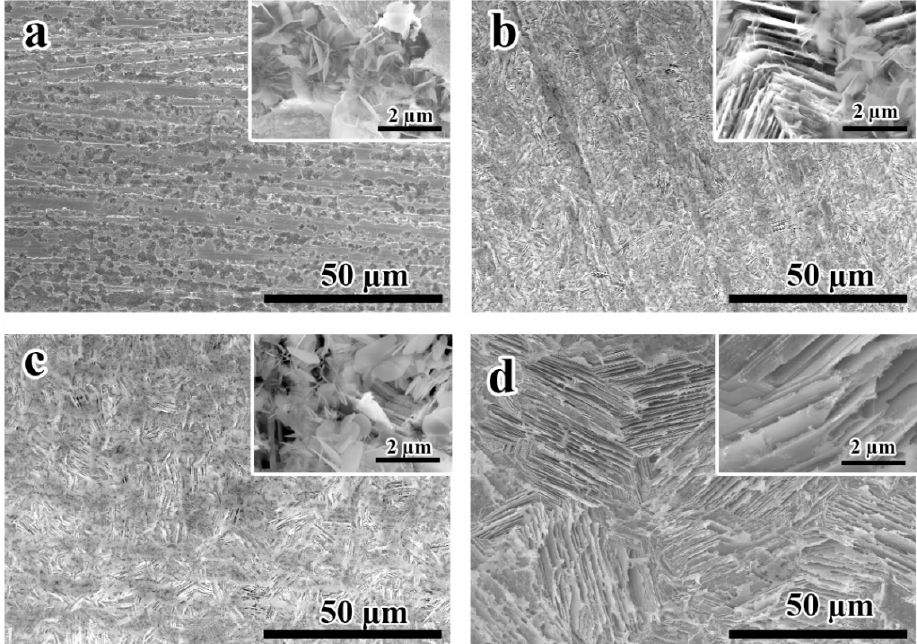
Figure 2. SEM micrographs of different anodization time: ( a ) 30 s, ( b ) 3 min, ( c ) 8 min, and ( d ) 30 min.